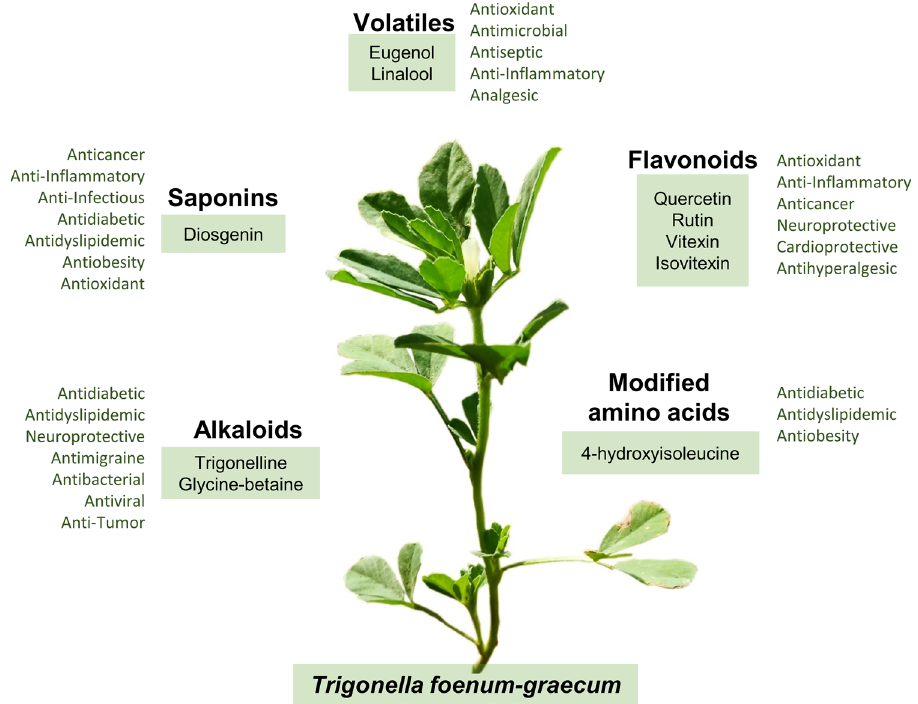
Figure 1. A snapshot of selected secondary metabolites produced by Trigonella foenum-graecum (shown in image is the AFG-1 variety). The abundance of these compounds make fenugreek a repertoire of nutraceutical and pharmaceutical